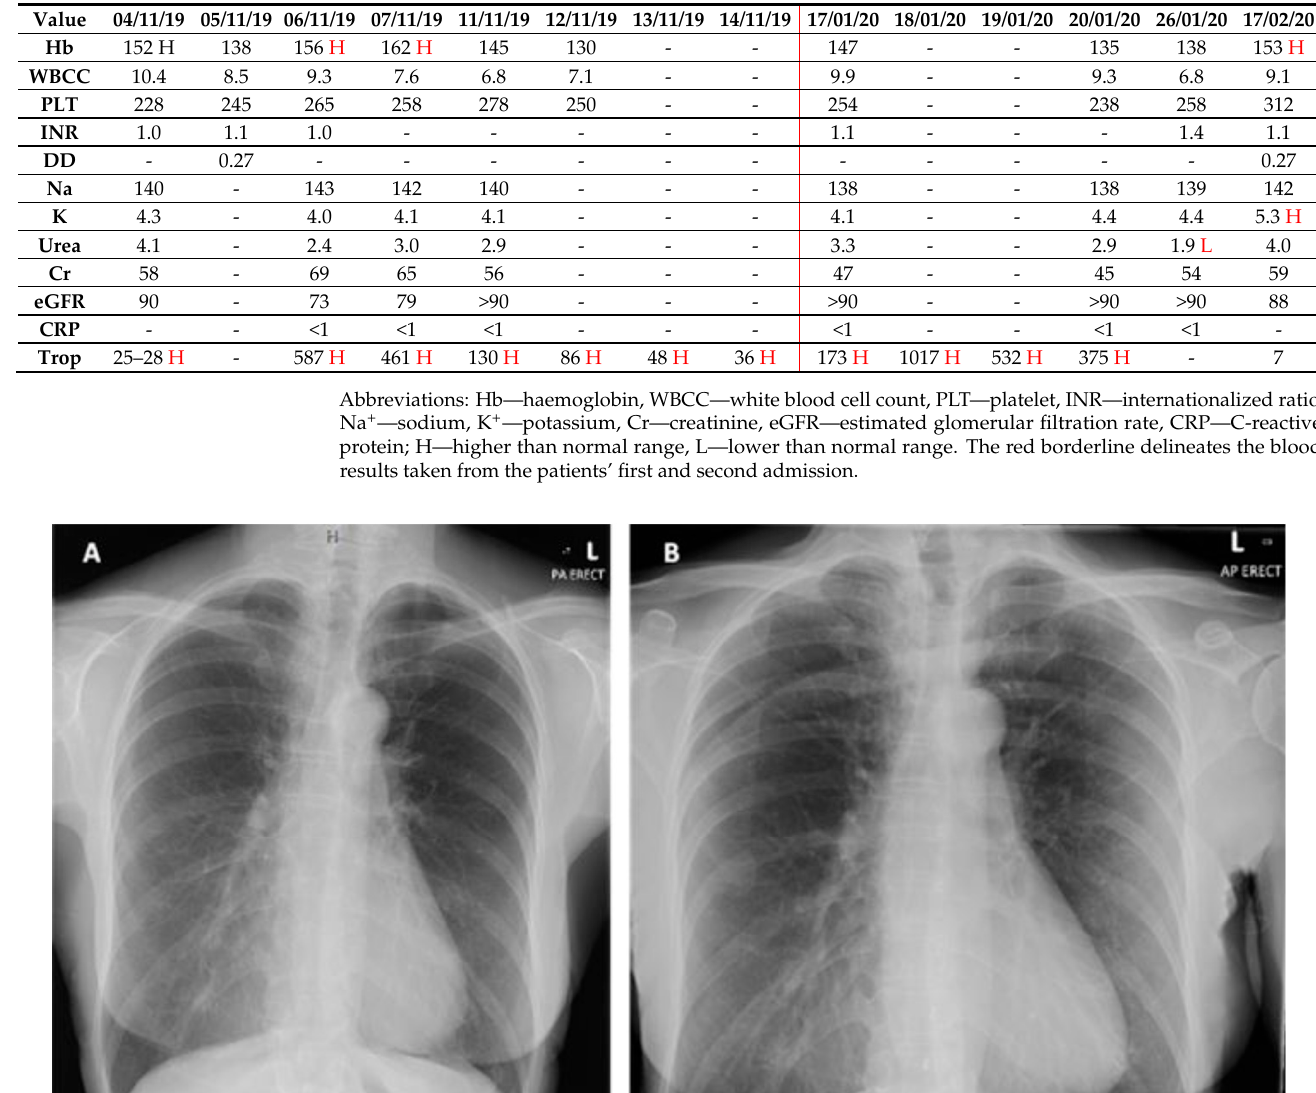
Table 1. Hematology results taken on both admissions.